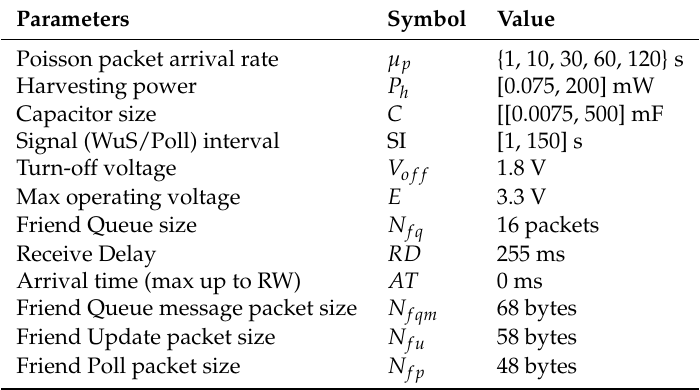
Table 2. Simulation